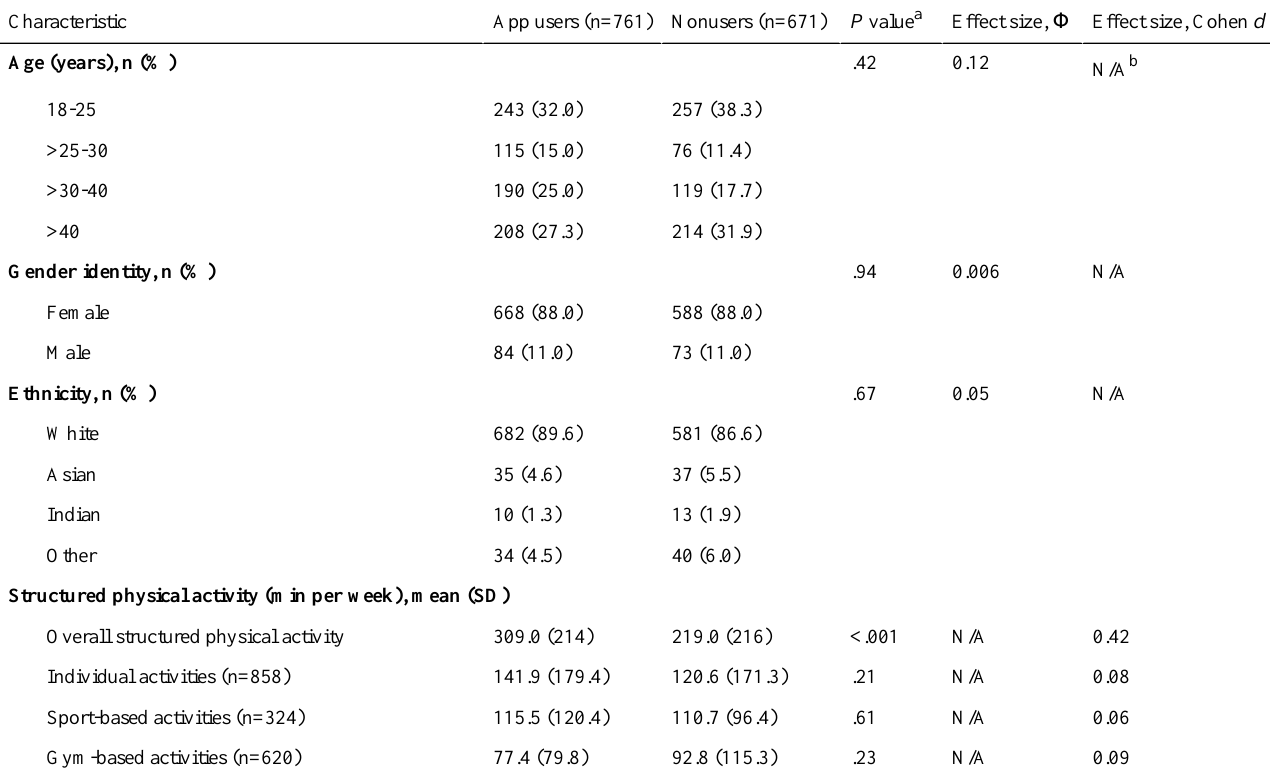
Table 1. Sample characteristics of physical activity app users and nonusers